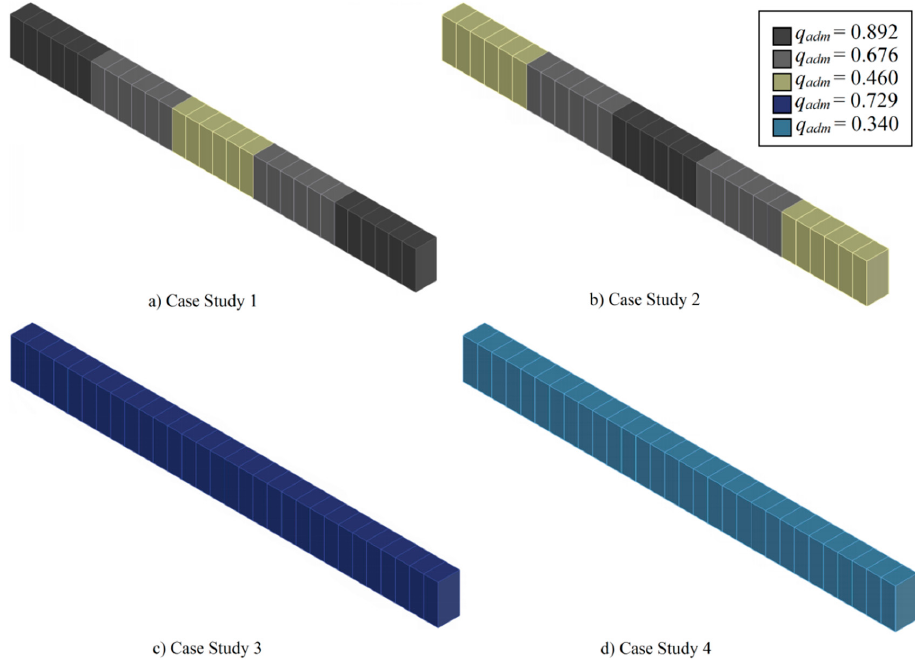
Figure 4. The thermal load of the racks according to every case study.